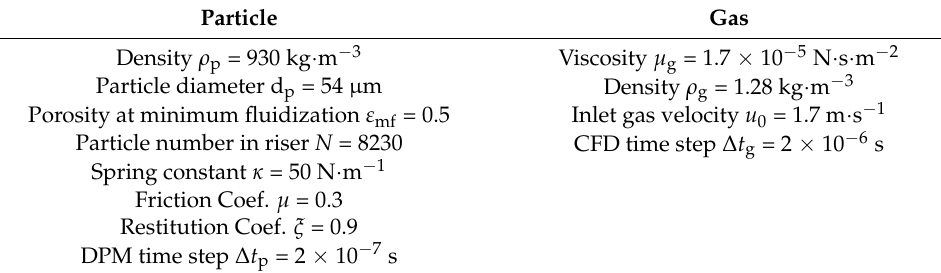
Table 1. Fixed parameters for particle and